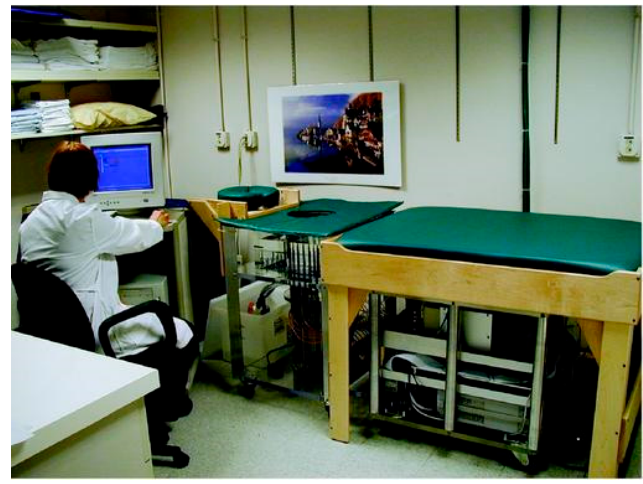
Figure 2. Microwave Imaging system at Dartmouth College [37].